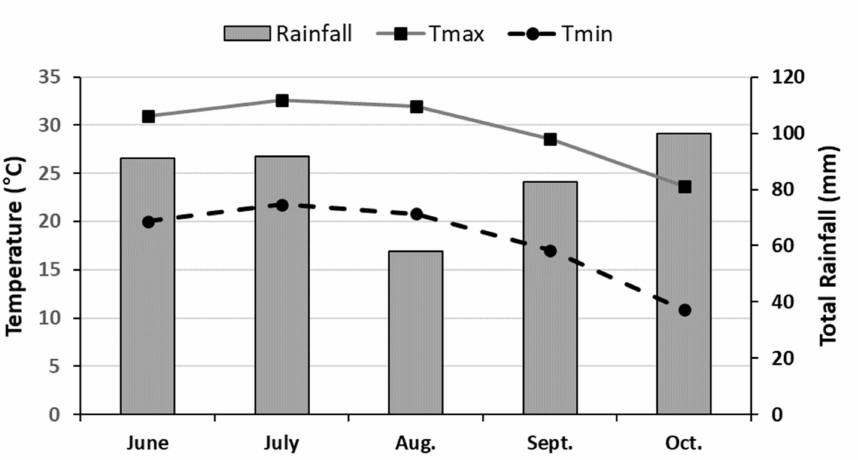
Figure 2. Maximum temperature, minimum temperature, and total rainfall during soybean grow- ing season (June–October) across study years from 2003 to 2018 at the Agricultural Research and Extension Center in South Jeolla province, South